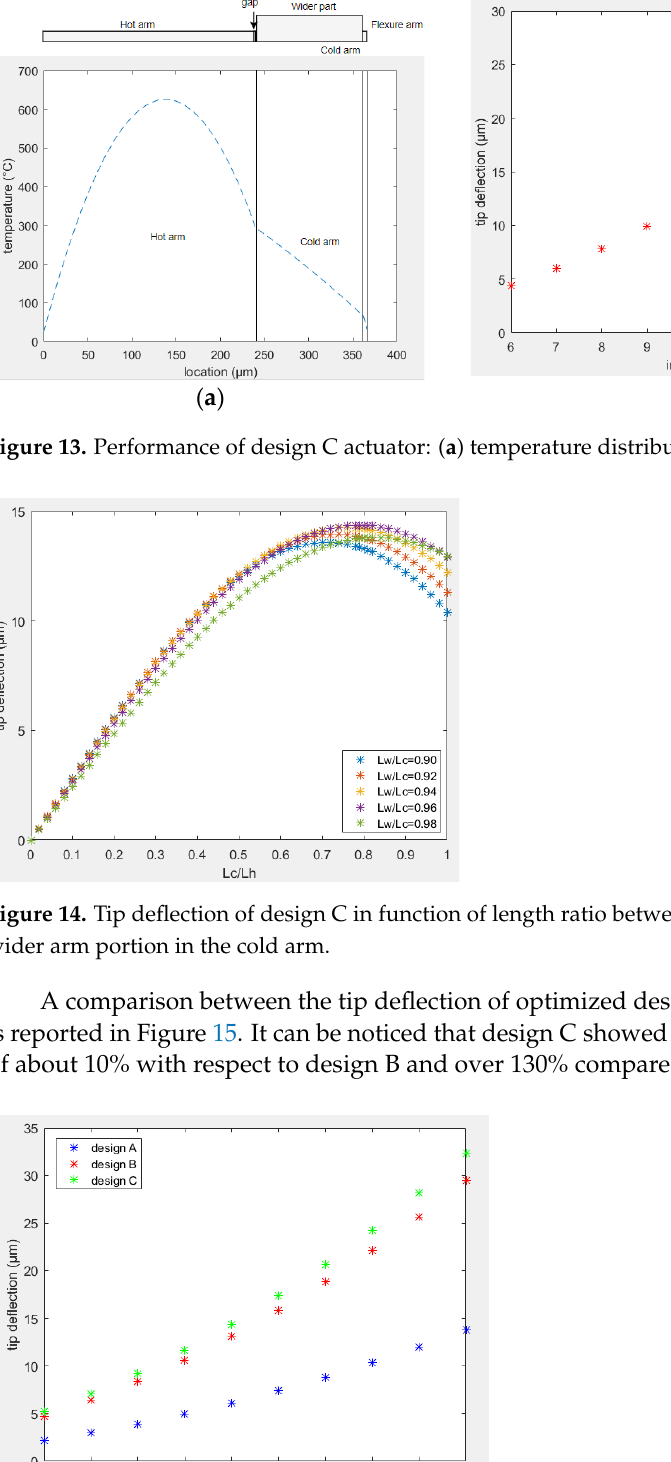
Figure 15. Tip deflection in function of input voltage of design C compared to designs A and B.